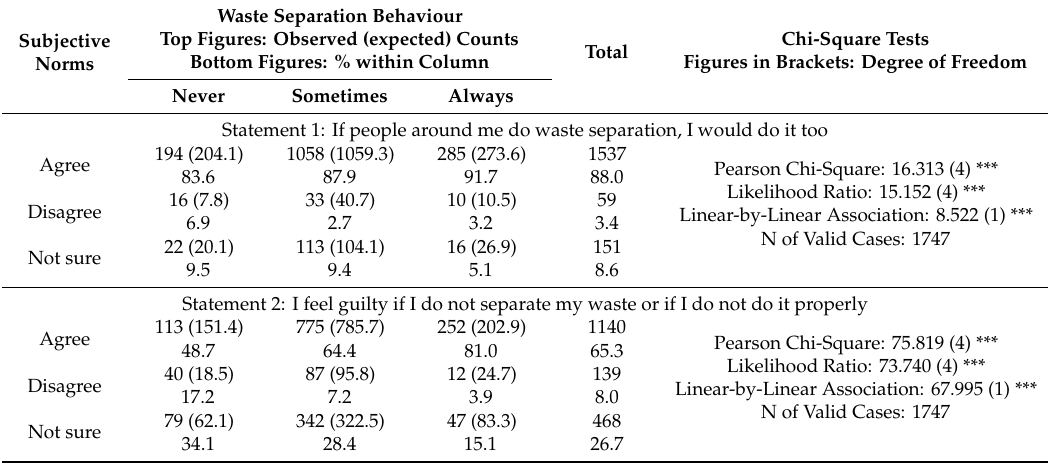
Table 8. Subjective norms and waste separation